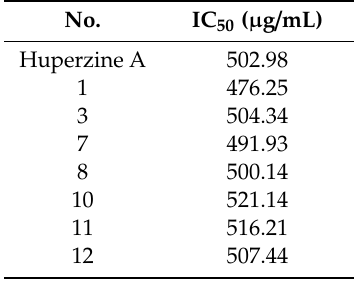
Table 10. Acetylcholinesterase inhibitory activity inhibition test